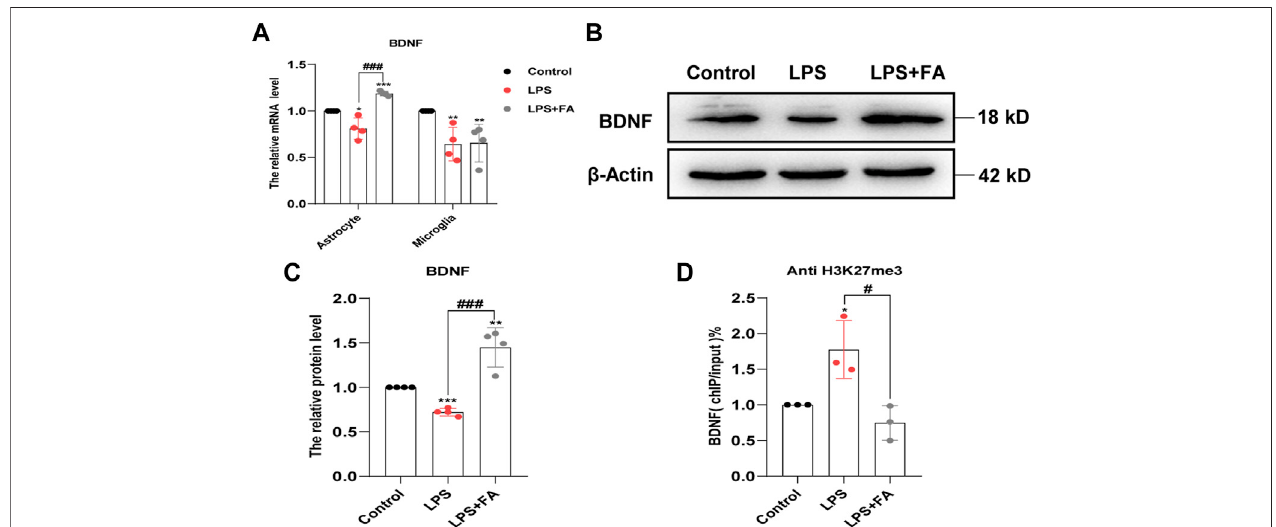
FIGURE8| FAregulatedtheexpressionofBDNFinastrocytes. (A) Quanti fi cationofthemRNAlevelsofBDNFinprimaryastrocytesandmicroglia.FAhadaneffect on the BDNF levels only in astrocytes. (B,C) Representative images and quanti fi cation of Western blotting analysis of the BDNF expression in astrocytes. (D) Primary astrocyteswere immunoprecipitated withanti-H3K27me3 antibody, and theisolated DNAwas analyzed byusing BDNF ChIP-qPCR primers. Rabbit IgG wasused asa negativecontrol.DNAfromeachChIP-qPCRsamplewasnormalizedbythecorrespondinginputsample.ComparedwiththeLPSgroup,thelevelofH3K27me3in the BDNF promoter region decreased signi fi cantly in FA-treated astrocytes. Data: mean ± SEM; * p < 0.05, ** p < 0.01, *** p < 0.001 versus the control group; # p < 0.05, ### p < 0.001 versus the PIA group; n = 3 – 4 per group (one-way